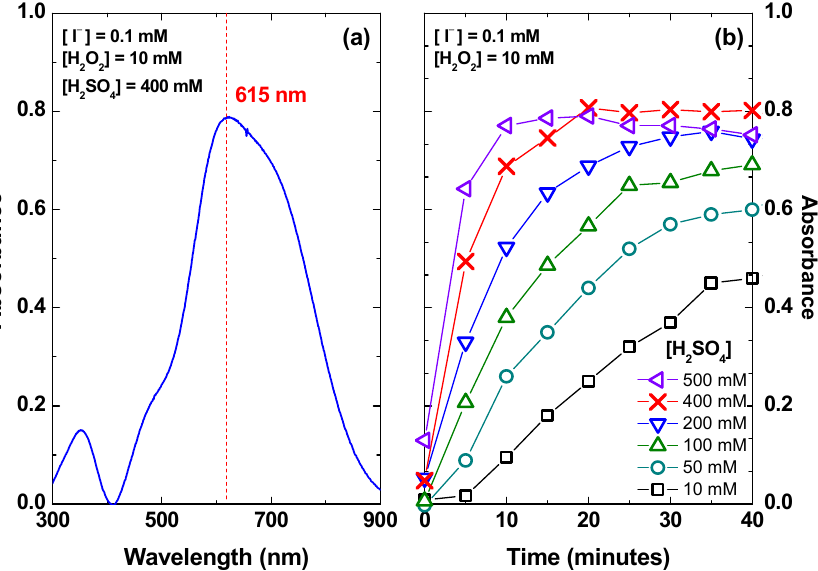
Figure 1. ( a ) UV/Vis absorption spectrum of iodine–starch complex; and ( b ) the absorbance at 615 nm, measured as a function of reaction time at various H 2 SO 4 concentrations.